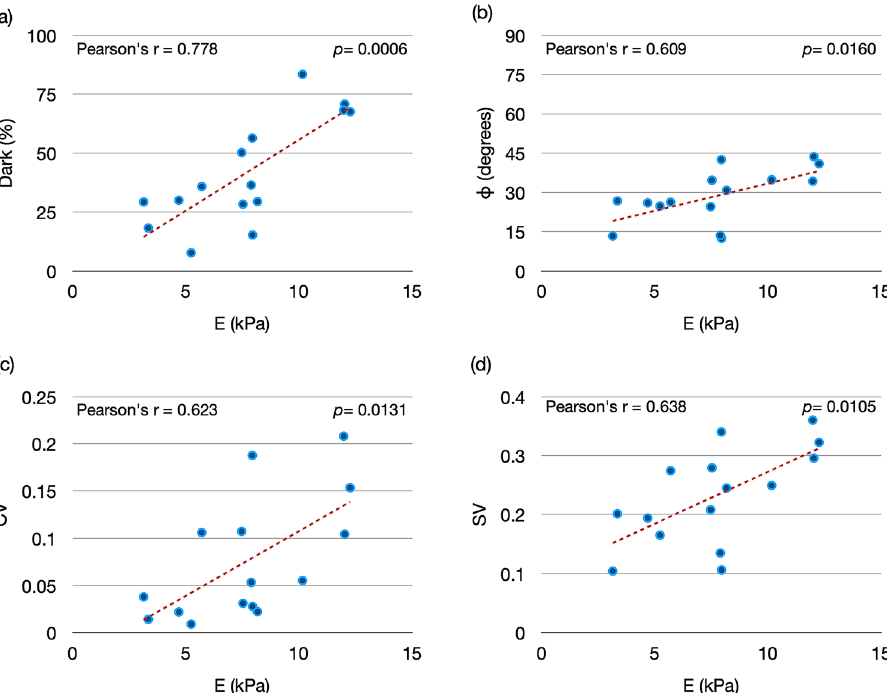
Figure 6. Correlation between the 3D microstructural data and NI results. The indentation modulus has a significant positive correlation with each microstructural parameter. The highest Pearson correlation coefficient was with the dark parameter (0.778), followed by SV (0.638), CV (0.623), and shows the linear